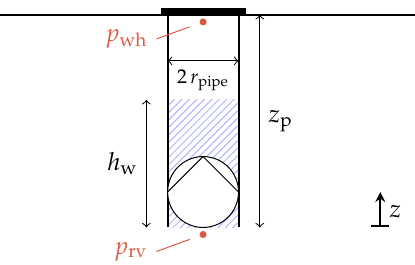
Figure 10. Hydraulic system of the geothermal production